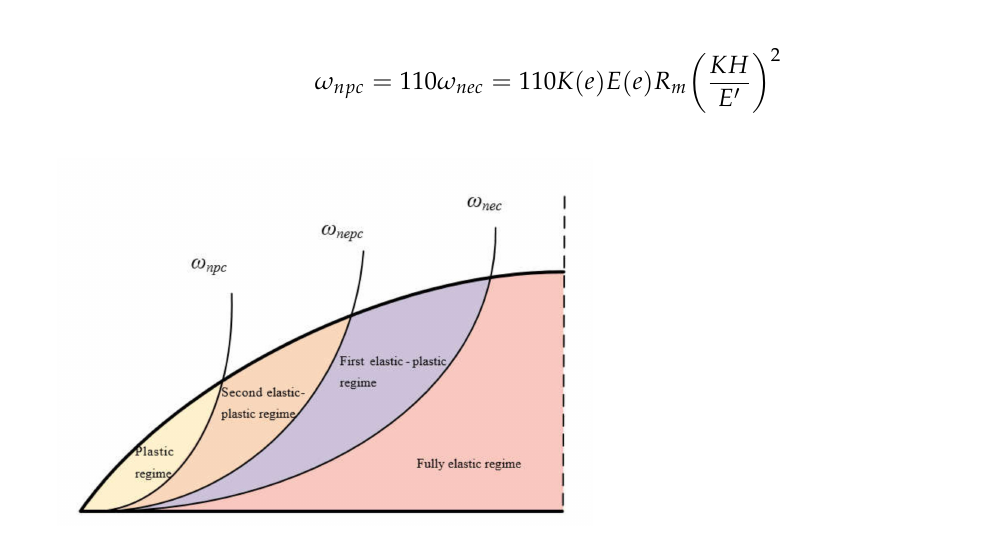
Figure 5. Relationship between the actual deformation ω n of asperity and the deformation